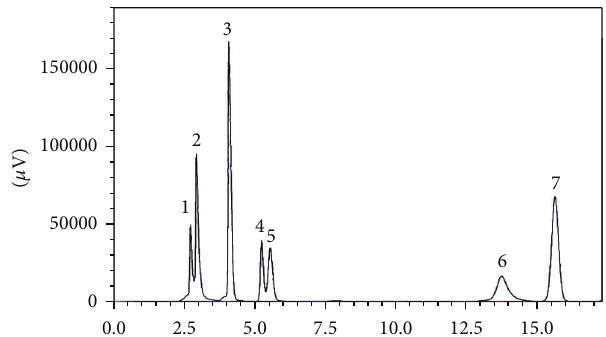
Figure 2: HPLC analysis of standards; 1 = tannic acid, 2 = gallic acid, 3 = catechin, 4 = hesperidin, 5 = rutin, 6 = quercetin, and 7 = cinnamic acid.